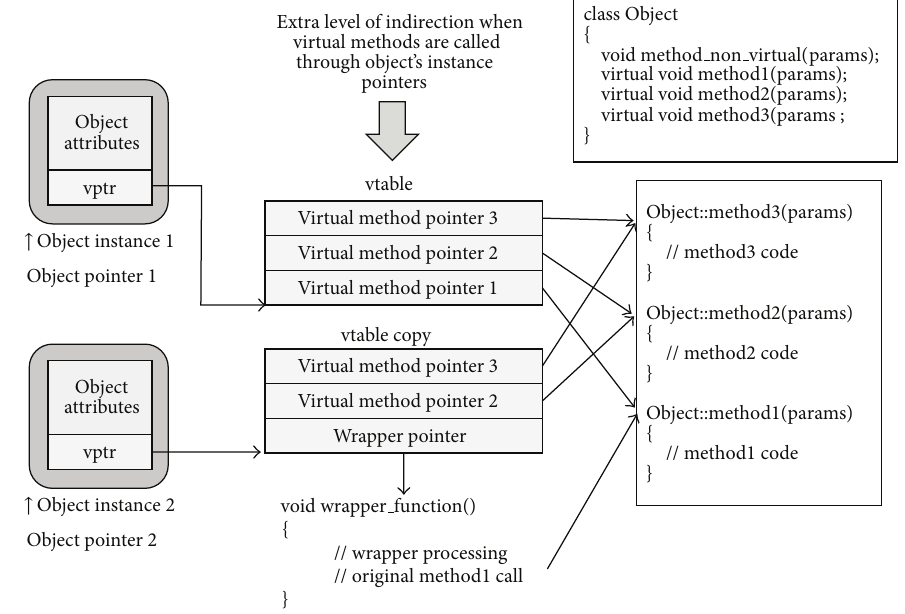
Figure 4: C++ virtual table basic